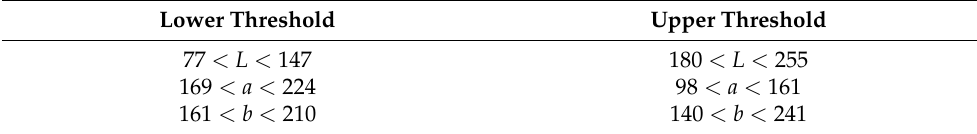
Table 4. Threshold values for the L*a*b colorspace.